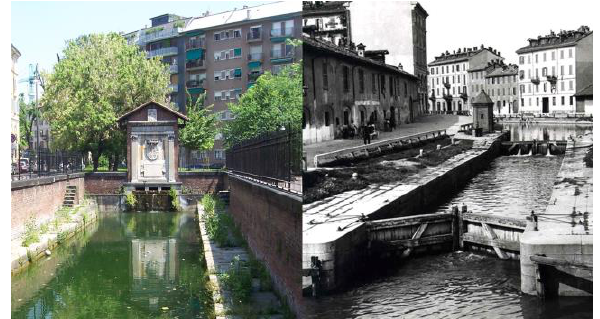
Figure 5 . The Conca dell’Incoronata, Milan. Italy: (a) today; (b) historical photos.